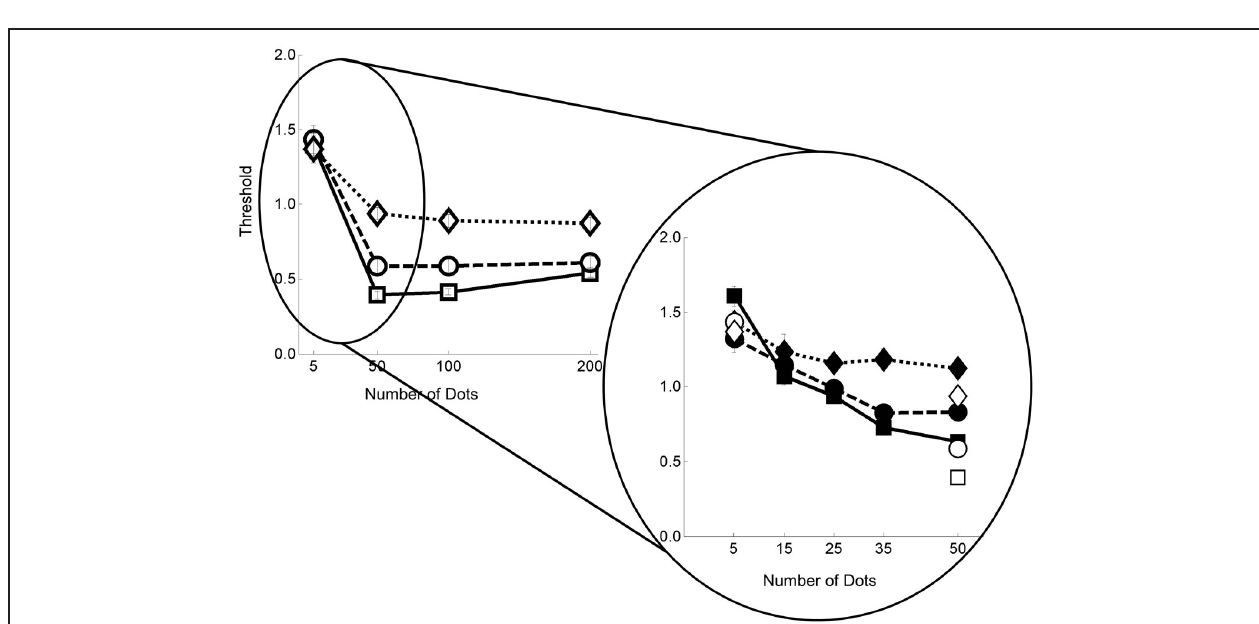
noise; circles with dashed lines for noise level 1; and diamonds with dotted lines for noise level 2. Filled shapes represent the 5–50 data and hollow shapes the 5–200 data. Error bars represent standard errors.